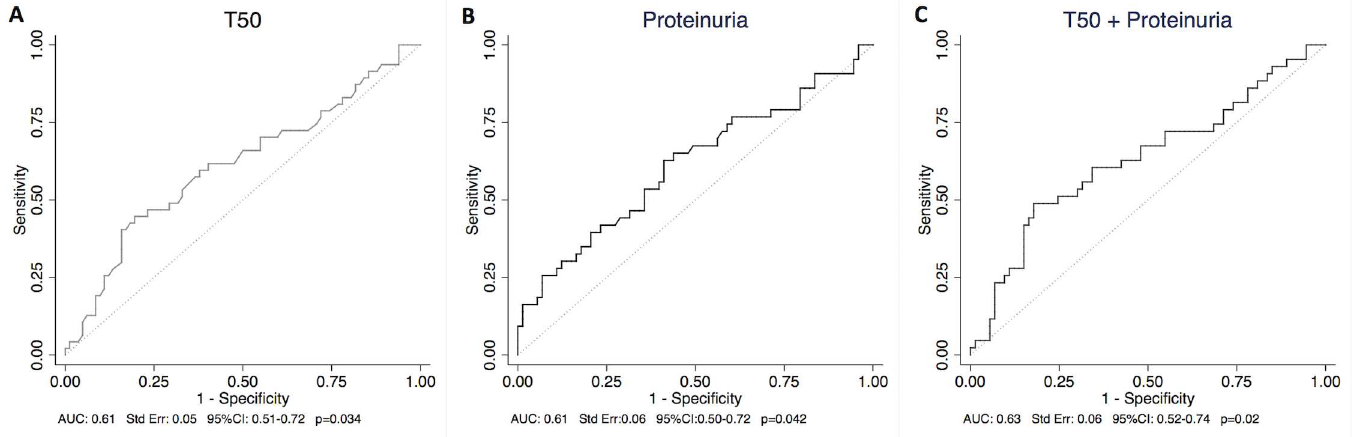
Fig 5. Vascular lesions estimated by BANFF: ROC curve of (5A) T 50 and (5B) proteinuria in predicting significant vascularlesions (BANFF cv+ah +aah > 5). (5C) ROC curve of T 50 and proteinuriacombined.Ah: arteriolarhyalinethickening; aah: circumferentialhyalinearteriolarthickening; AUC: Area Under the Curve; cv: vascular fibrous intimal thickening; ROC: Receiver OperatingCharacteristic; T 50 : Calcification propensity.